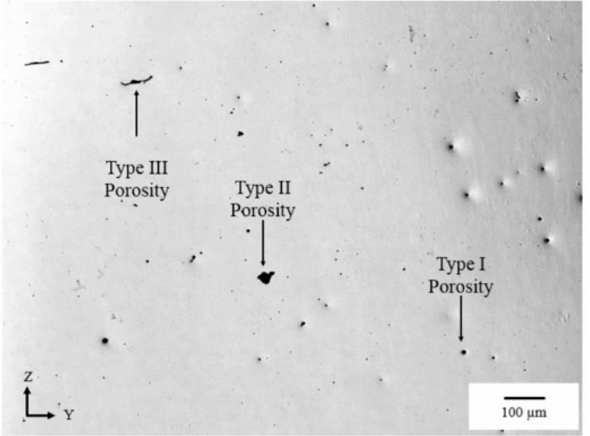
Figure 11. Optical micrographs of 90-BF-F AM show typical defects observed in all samples (material: 17–4 steel). The loading direction is perpendicular to the page, and the building direction is parallel to the Z -direction